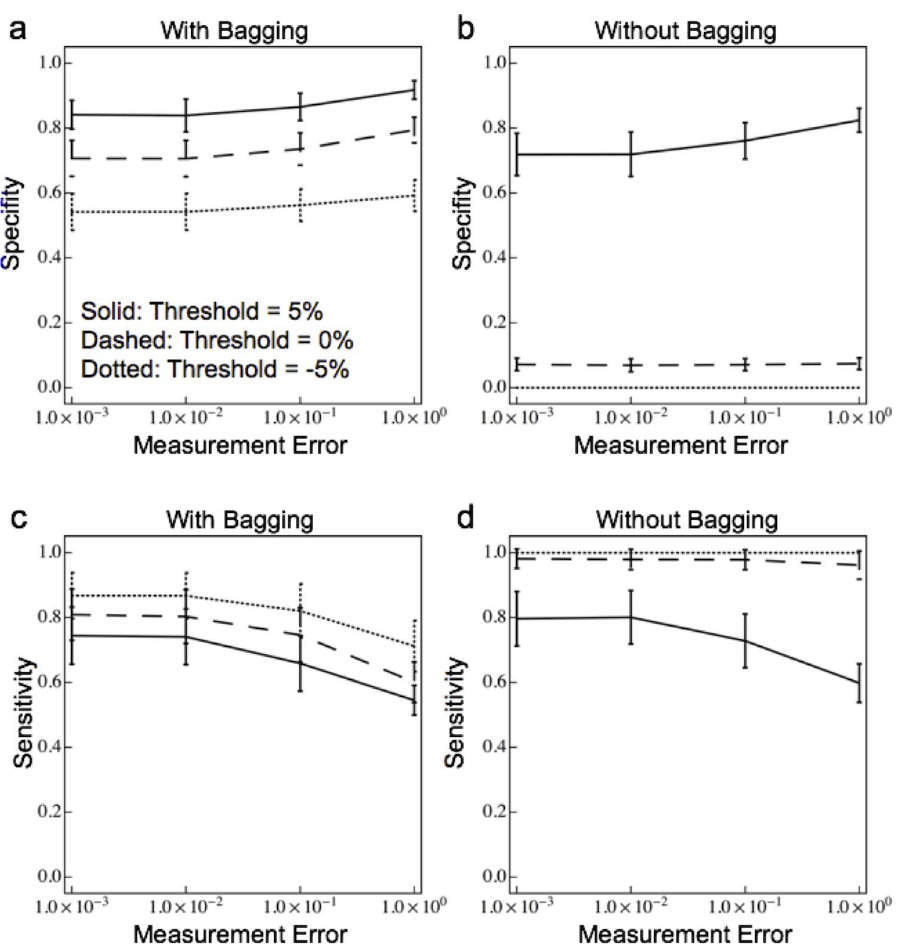
Figure 5. Sensitivity and specificity of predicted interactions as a function of measurement error for bagged and unbagged models. Specificity refers to the fraction of species pairs correctly identified as non-interacting, while sensitivity refers to the fraction of species pairs correctly identified as interaction. Both measures range from 0 (poor performance) to 1 (good performance). a) Specifity of sparse linear regression with Bagging as a function of measurement error for different prediction error thresholds. b) Specificity of sparse linear regression trained on the entire data set without Bagging as a function of measurement error for different prediction thresholds. c) Sensitivity of sparse linear regression with Bagging as a function of measurement error for different prediction error thresholds. d) Sensitivity of sparse linear regression trained on the entire data set without Bagging as a function of measurement error for different prediction error thresholds. Notice that without bagging, model performance is extremely sensitive to choice of the threshold for the required improvement in prediction for adding new interactions.